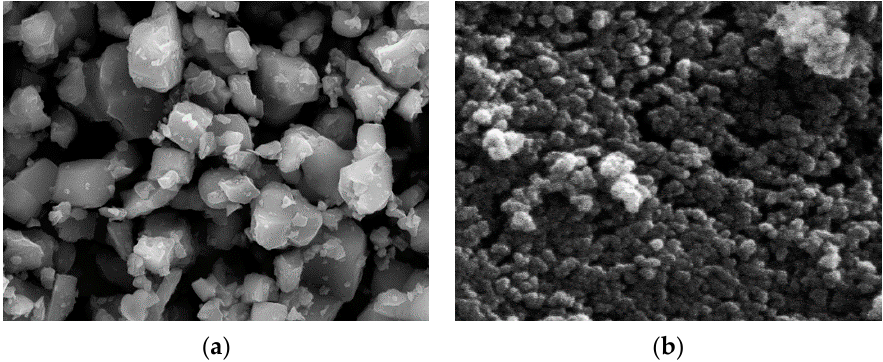
Figure 1. The micro morphology image of pre-placed cladding powder: ( a ) TiCN; ( b ) SiO 2 .